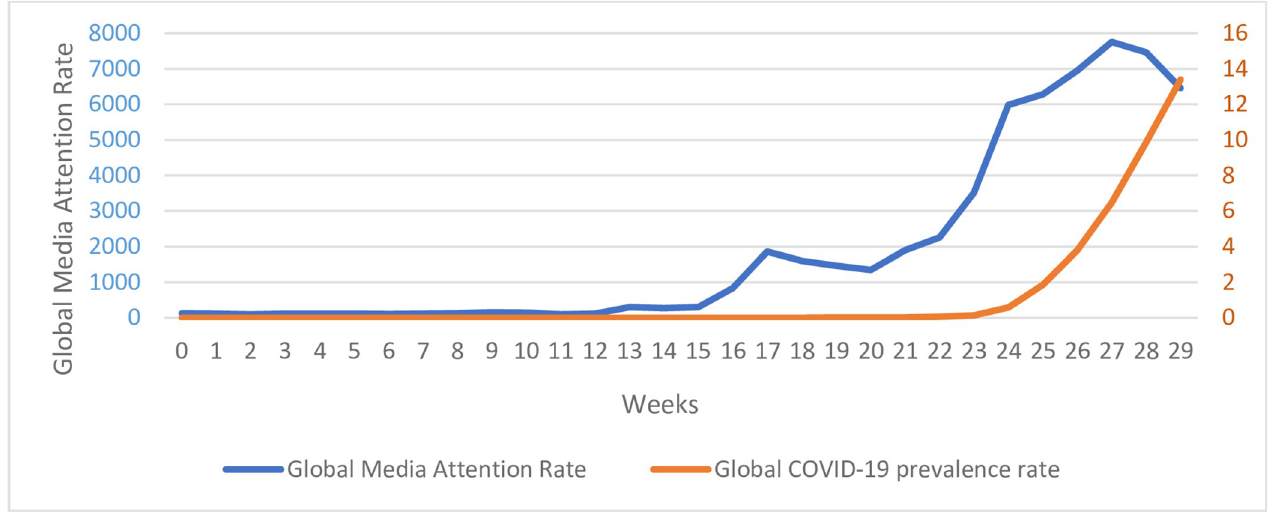
Fig 1. Global media attention rate and COVID-19 prevalence rate from a baseline period (Oct-Dec’19) to during the pandemic (Jan-May’20).